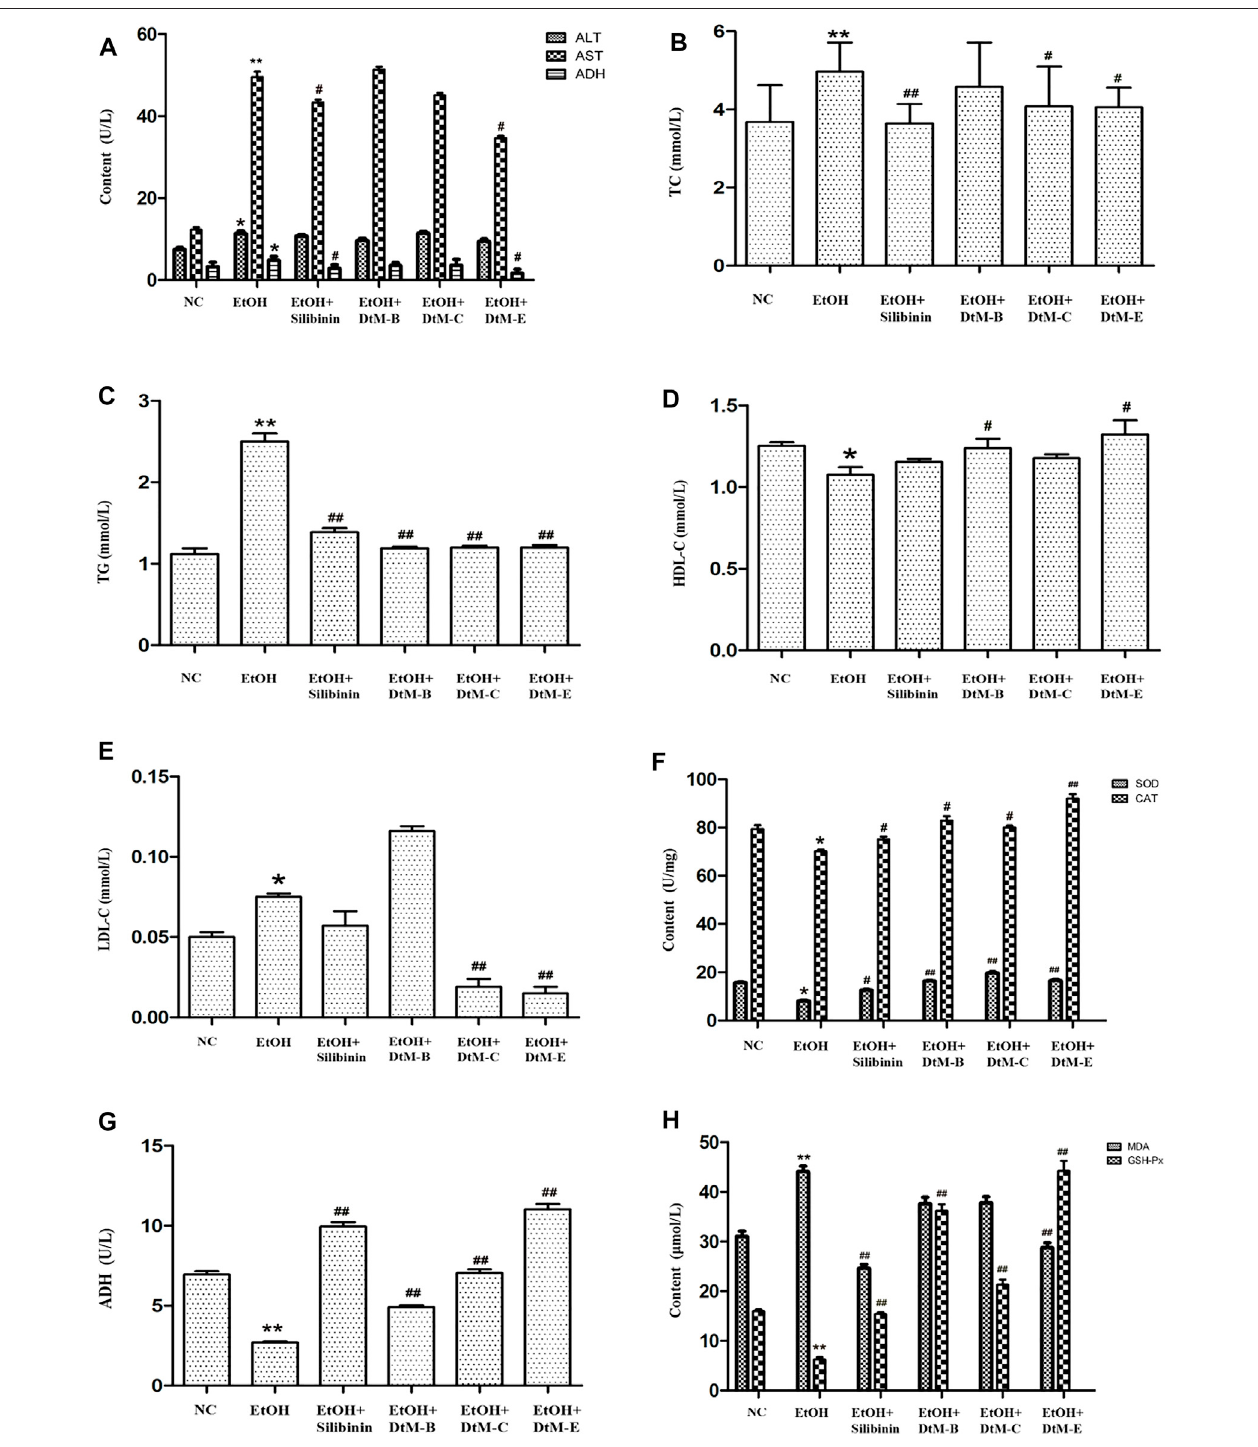
FIGURE1 | Results ofthe detection ofbiochemical indicators. (A) Detection ofserum liver function indicators: alanine transaminase (ALT), aspartate transaminase (AST), and alcohol dehydrogenase (ADH). (B – E) Detection of serum hepatic lipids: total cholesterol (TC), triglyceride (TG), high-density lipoprotein cholesterol (HDL-C), and low-density lipoprotein cholesterol (LDL-C). (F – H) Detection of lipid peroxidation: alcohol dehydrogenase (ADH), malondialdehyde (MDA), superoxide dismutase (SOD), catalase (CAT), and glutathione peroxidase (GSH-Px) in liver tissue. All data are presented as mean ± SD ( n = 10). * p < 0.05 and ** p < 0.01 ( vs . control group); # p < 0.05 and ## p < 0.01 ( vs . model group).